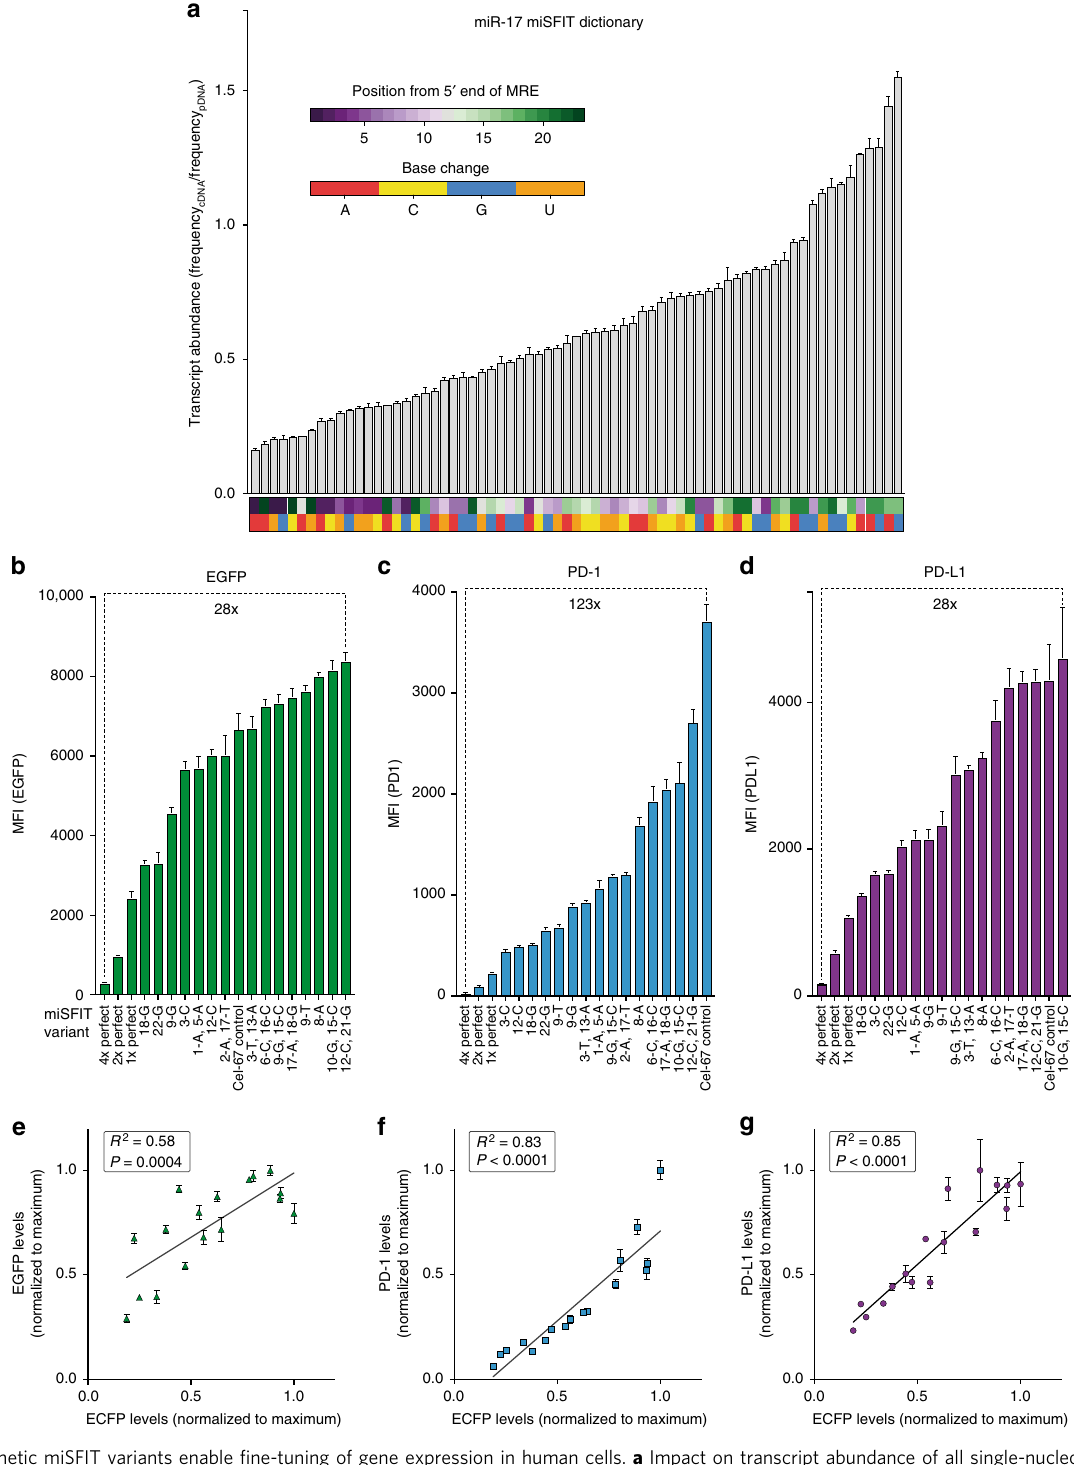
Fig. 2 Synthetic miSFIT variants enable fi ne-tuning of gene expression in human cells. a Impact on transcript abundance of all single-nucleotide miR-17 miSFIT variants ranked by expression output. Coloured rectangles beneath each bar indicate the position (top) and base change (bottom) of the synthetic MRE variant ( n = 3 biological replicates, mean + s.d.). b – d Flow cytometry analysis of HEK-293T cells transfected with a panel of 19 miR-17 miSFIT variants placed in the 3 ′ UTR of EGFP ( b ), PD-1 ( c ), and PD-L1 ( d ) ( n = 3 biological replicates, mean + s.d.). Fold-change between maximum and minimum expression is noted for each transgene. e – g Linear regression analysis of miSFIT strength correlation between ECFP-EGFP ( e ), - PD-1 ( f ), and - PD-L1 ( g ) in HEK-293T cells ( n = 3 biological replicates, mean + s.d.). P values indicate slopes signi fi cantly differ from 0. Source data are provided as a Source Data fi